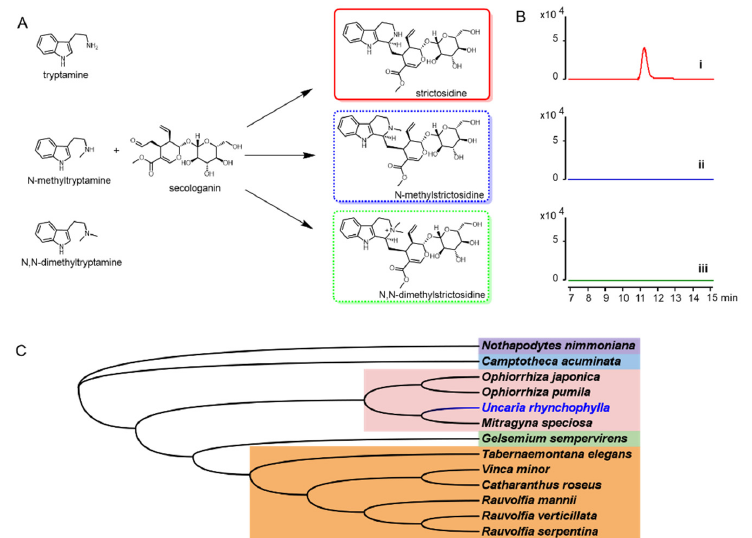
Figure 7. ( A ) tryptamine and analogues were proposed to be accepted by Ur STR for strictosidine and analogue formation. ( B ) biochemical characterization of Ur STR in vitro. (i) with tryptamine, (ii) with N-methyltryptamine and (iii) with N-dimethyltryptamine. ( C ) phylogenetic tree of STRs from indole alkaloids producing plants.